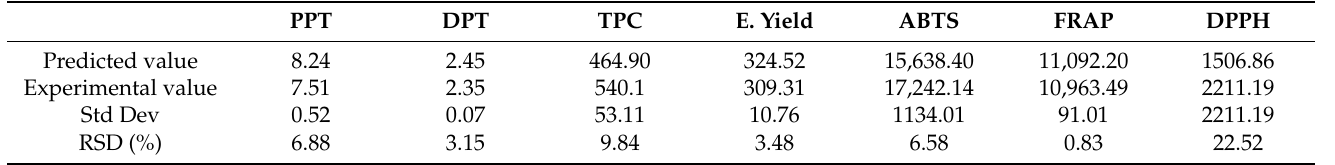
Table 4. Predicted and experimental values under optimum conditions resulting from the simultane- ous optimization of the eight